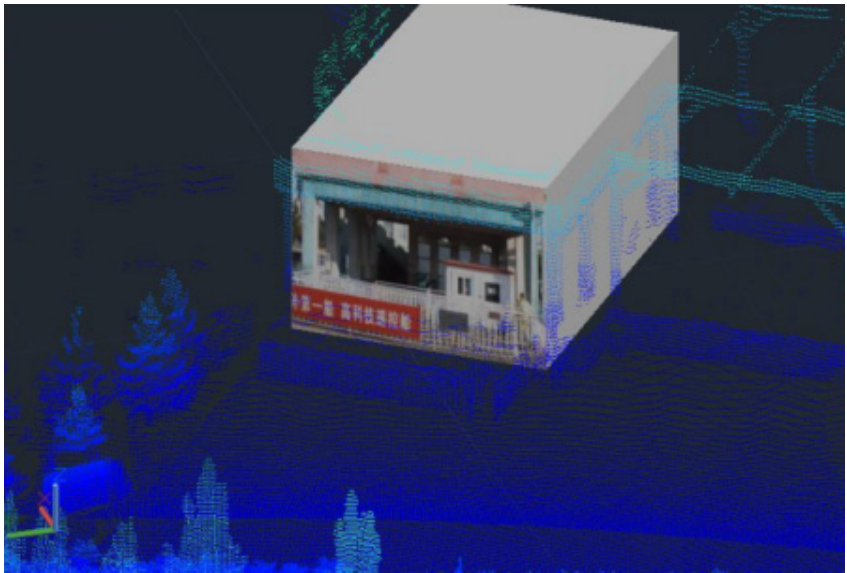
Figure 18. Building simple model rapid creation based on street view image and LIDAR data.